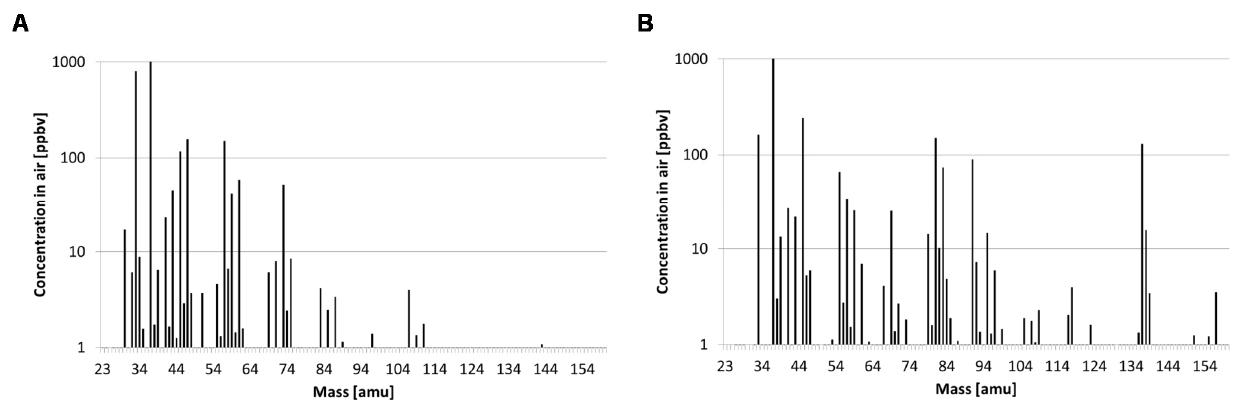
Figure 3. Mean PTR-MS (proton transfer reaction mass spectrometry) spectrum of C. majalis cultivated in The Netherlands: rhizomes ( A ) and flowers ( B